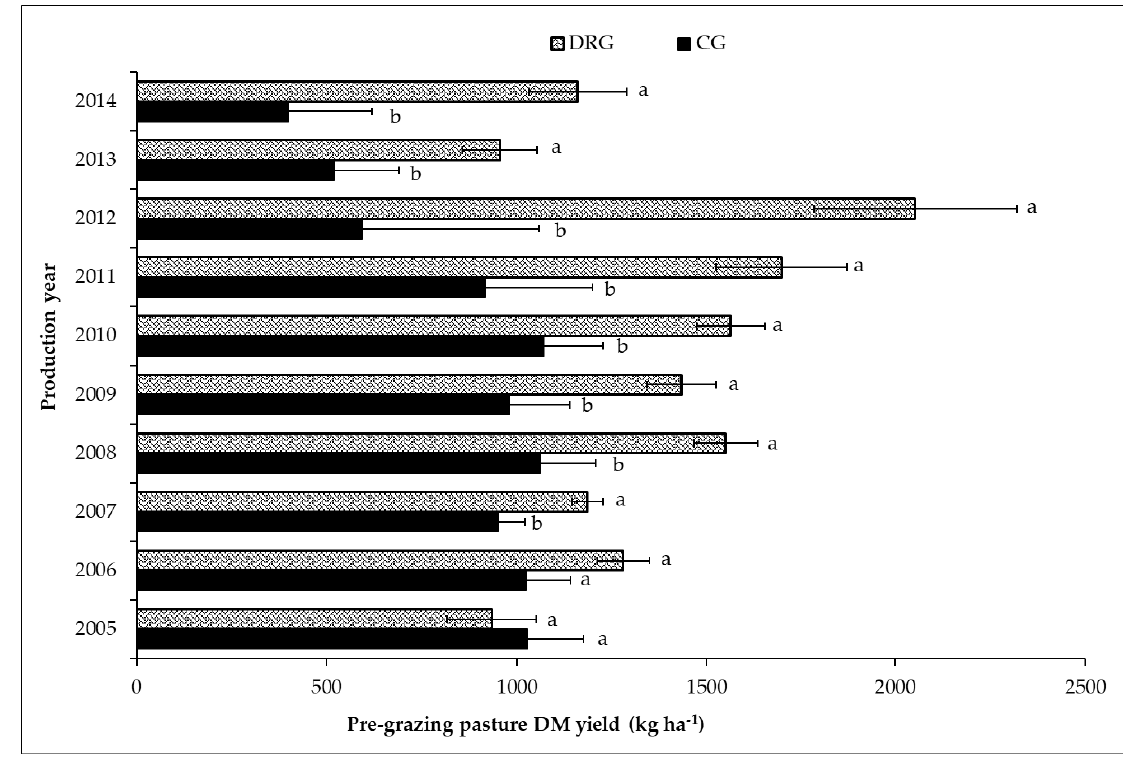
Figure 1. Pre-grazing pasture biomass yield (kg ha − 1 ) harvested at the end of June for the grazing system (CG = continuous grazing, DRG = deferred rotational) × year interaction ( p ≤ 0.05) over the experimental period. Significance difference among treatment within a year was indicated by lower case letters (a, b) and standard error of means was indicated by error bars.